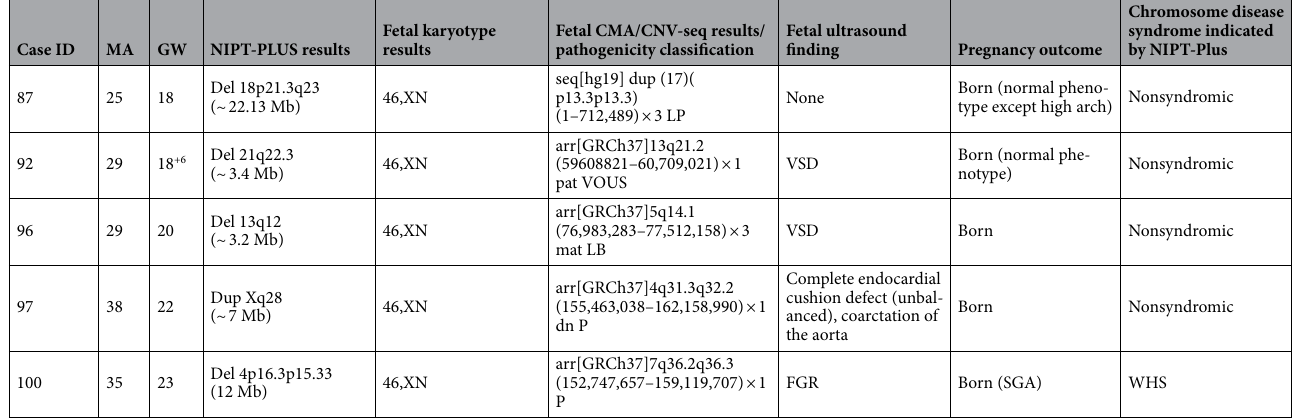
GW at NIPT n NIPT positive TP FP $ FN* Refused invasive testing PPV(%)